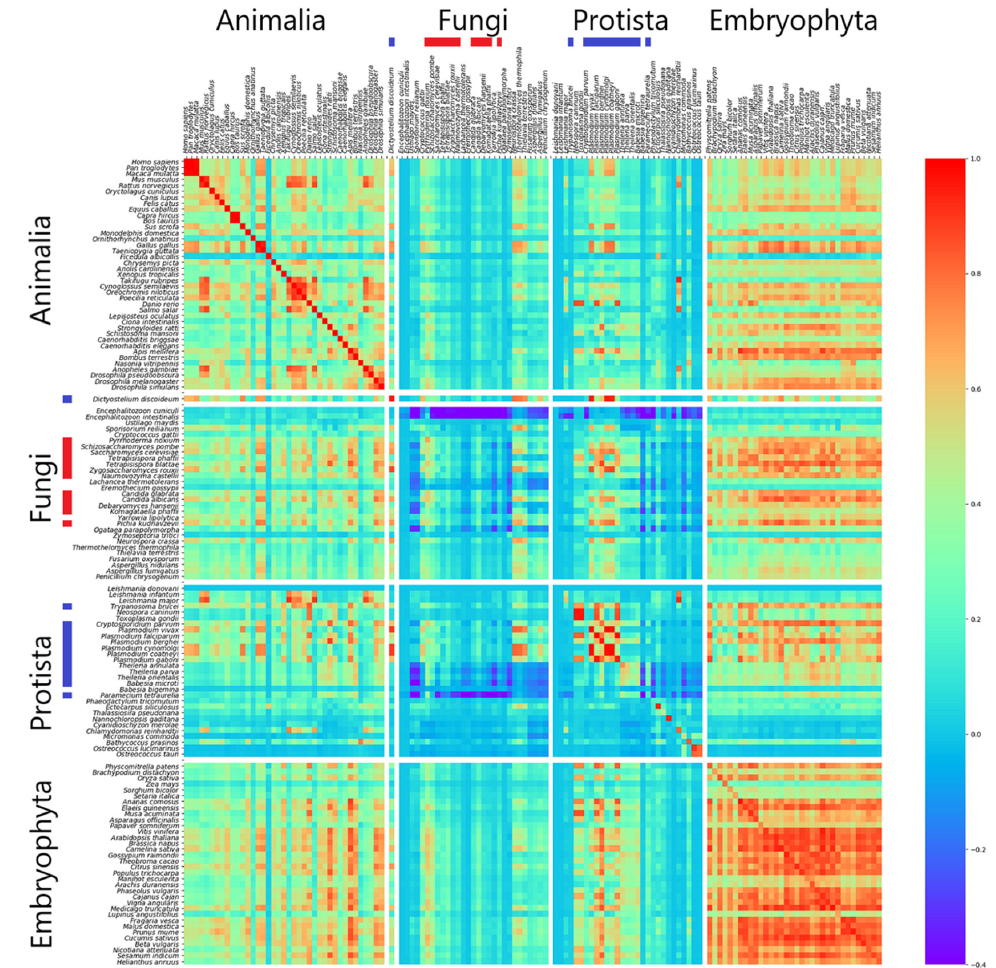
Figure 3. Heatmap showing correlation values between individual intronic and intergenic regions ( Animalia , Fungi , Protista and Embryophyta , k = 11). Each row represents the pairwise correlation values (Pearson correlation) of introns for the listed organism, while every column is associated with the intergenic region of an organism. Color scale is limited in heatmap to values above − 0.4 for better readability. Genomes belonging to subset 1 in Protista are labelled with blue bars, and those of subset 1 in Fungi are labelled with red bars on the axes. The protist Dictyostelium discoideum of subset #S1 of Protista is placed between Fungi and Animalia , as this very organism is a member of the Amoebozoa and has close relations to both kingdoms. Table 2. Correlation contributions of tandem repeats words ( k = 7) for different chain seed lengths b (1 ≤ b ≤ 3). The correlation contributions for correlations between different genomic regions analogous to the data shown in Figure 4 are shown. (E/P/F/A) stands for ( Embryophyta / Protista / Fungi/Animalia ).